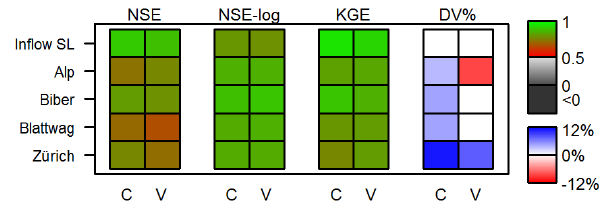
Figure 2. Results of calibration (C) and validation (V) of the modelling chain for different control points within the target area (cf. Fig. 1). SL stays for “Sihl Lake”. The measures of agreement are defined in Sect.